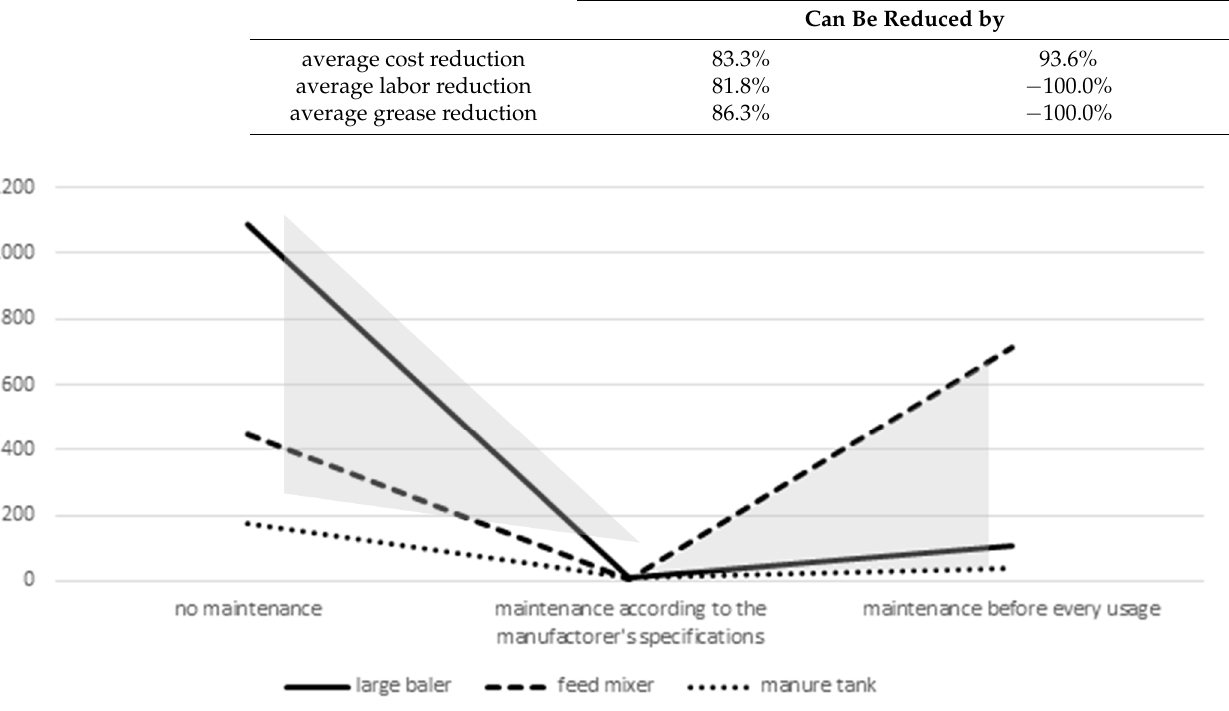
Figure 9. Visualization of costs for the three different maintenance scenarios.